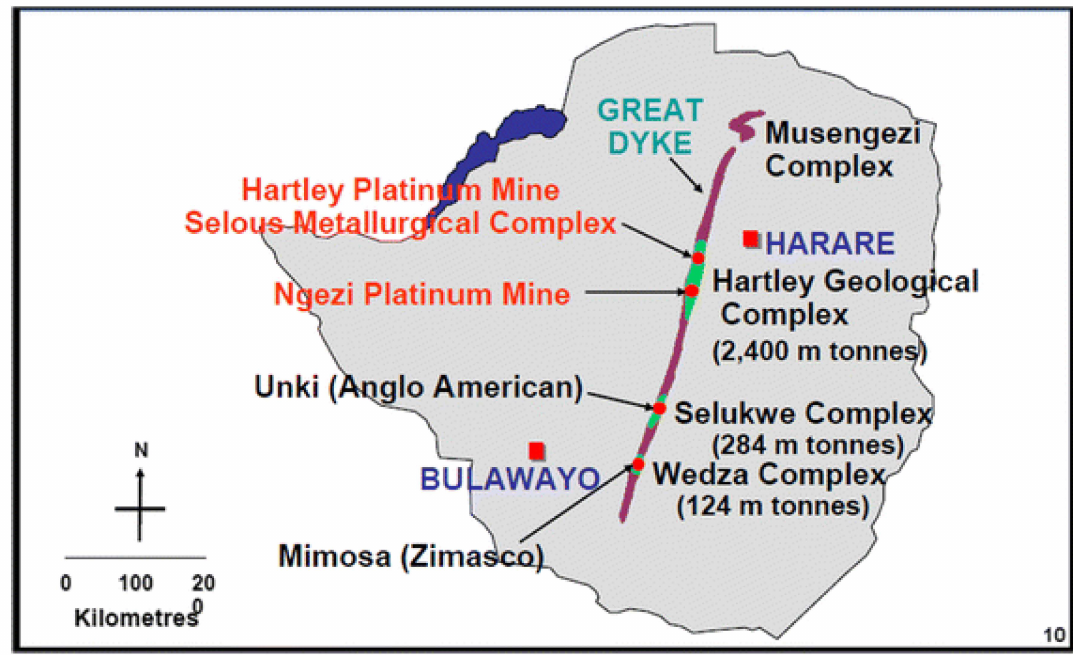
Figure 1. The Great